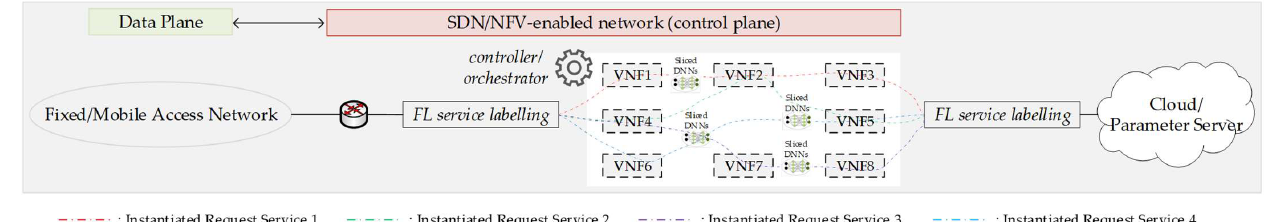
Figure 6. SDN-assisted control architecture for distributing DNNs.